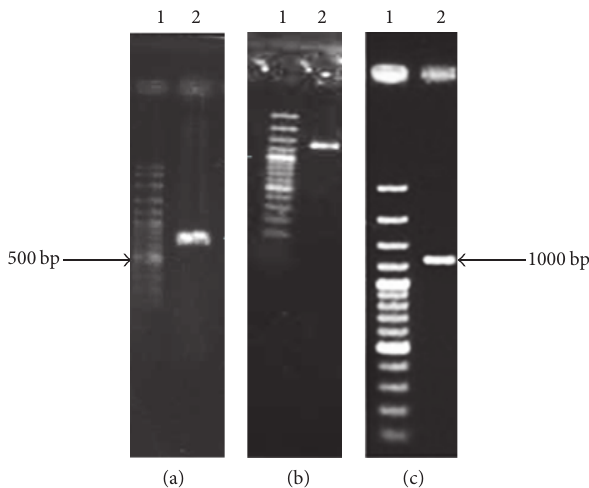
Figure 1: Results of amplification of TcpA, TcpB, and FlaA